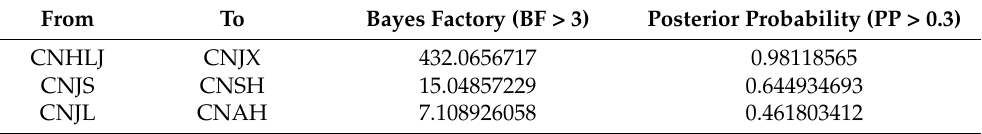
Figure 6. The transmission route of PKV within China. ( A ). Maximum clade credibility tree with annotated posterior probability on the ancestral nodes, depicting the Chinese spread of PKV. Lines with different colors represent different regions, CNAH (red lines), CNGD (yellow lines), CNGS (grass green lines), CNHLJ (reseda lines), CNHeN (bottle green lines), CNHuB (mint green lines), CNJL (blue lines), CNJ (purple lines), CNJX (amaranth lines), and CNSH (rose red lines). ( B ). Reconstruction of PKV transmission route within China. Table 2. Bayes Factor (BF) and Posterior Probability (PP) tests for PKV transmission links within China. From To Bayes Factory (BF >